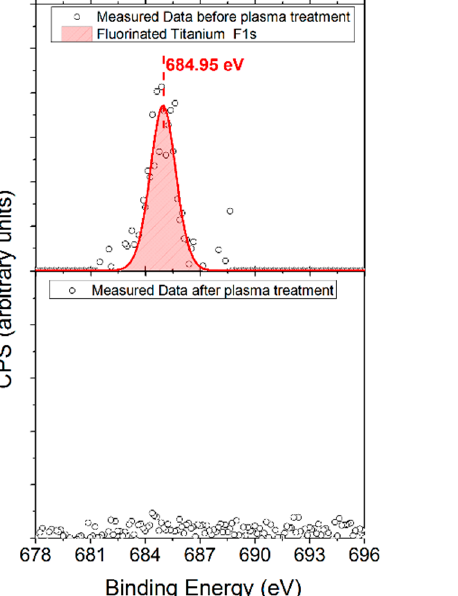
Figure 8. XPS spectra of Ti2p of cTi before and after oxygen plasma treatment.